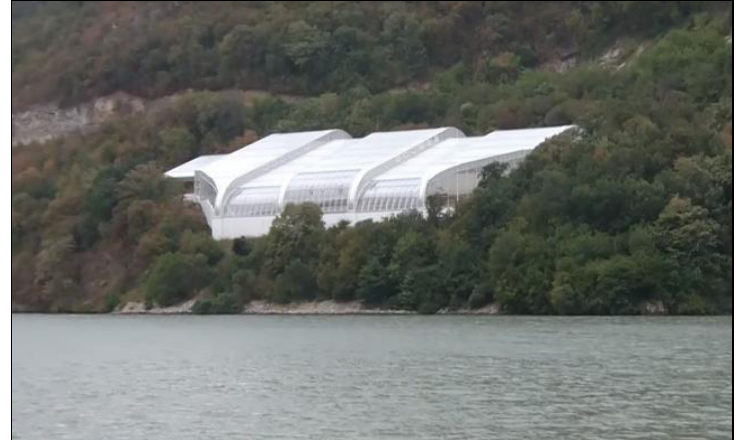
Figure 28. Side view of the steep background of Lepenski Vir and towards the Lepenski Vir Museum on the site above a sunken archaeological